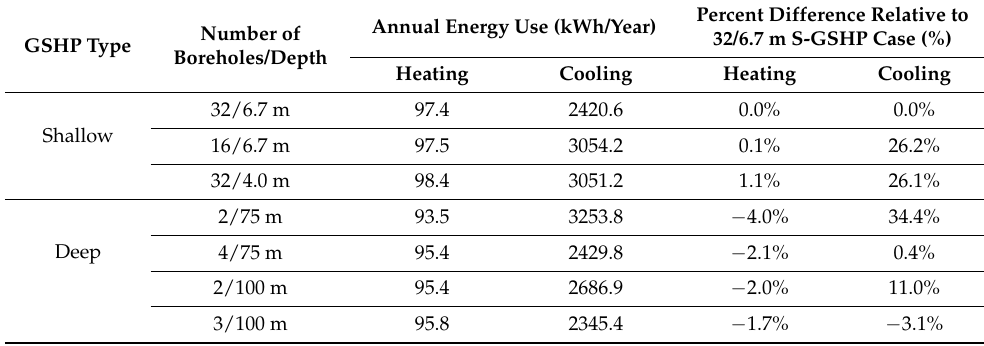
Figure 12. Impact of borehole depth on annual heating and cooling electricity end uses for 32 bore- holes with 6.7 m (22 ft) depth when the prototypical house is located in ( a ) Arcata, ( b ) Long Beach, and ( c ) Imperial. Table 5. Annual heating and cooling energy end uses for both deep and shallow GSHP systems when the house is located in Long